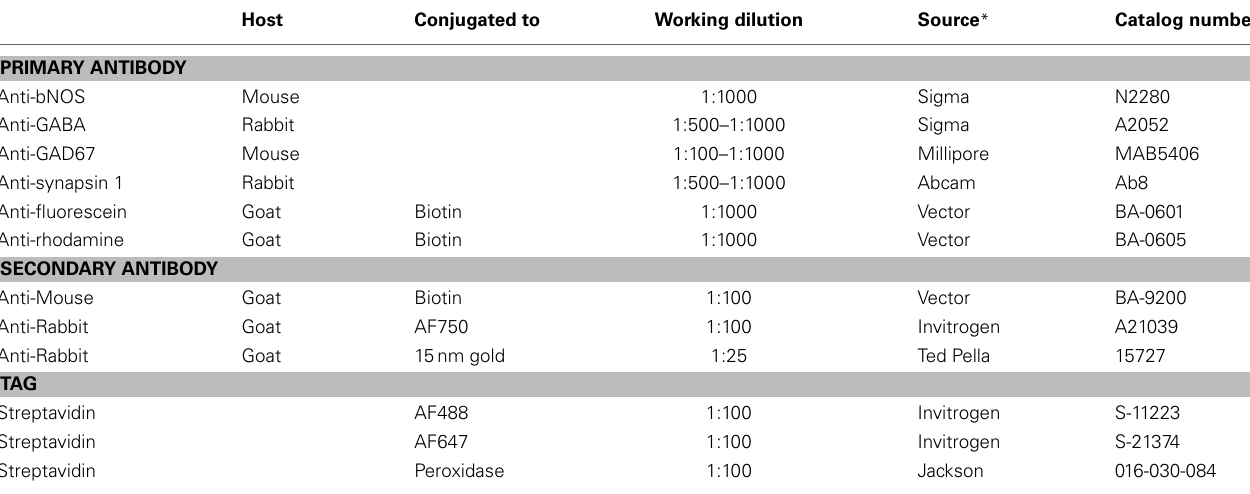
Table 2 | List of main reagents used for